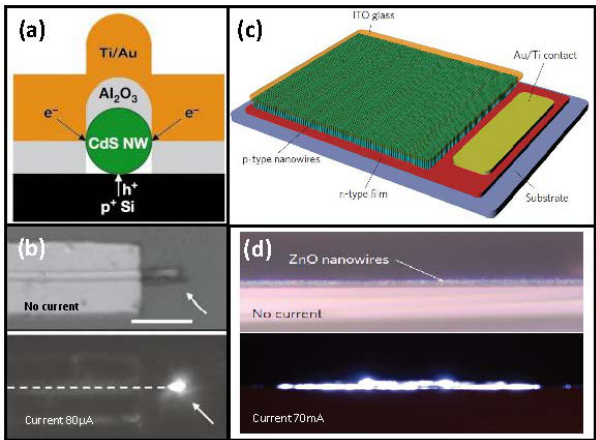
Figure 3: Electrically driven nanowire lasers made of CdS (left) and ZnO (right). (a, c) Schematics of the structures [17, 24]. (b) SEM im- ages of the device without (top) and with (bottom) current injection (adapted with permission [24]). (d) Side view under optical micro- scope observation: under illumination and without current injec- tion (top), without illumination and with current injection (bottom) (adapted with permission